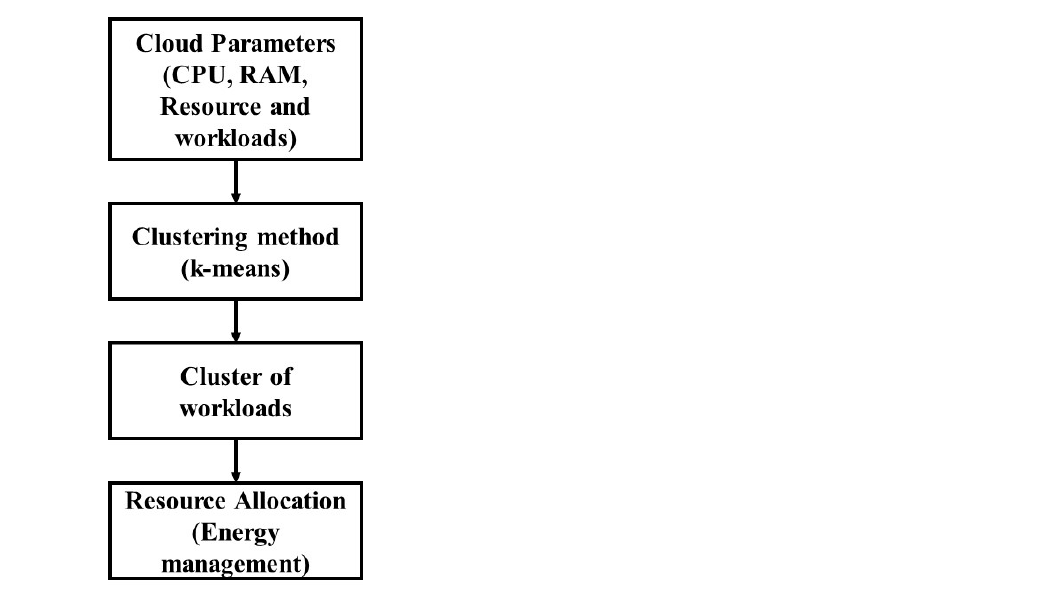
Figure 2. Overview of clustering method in energy management.